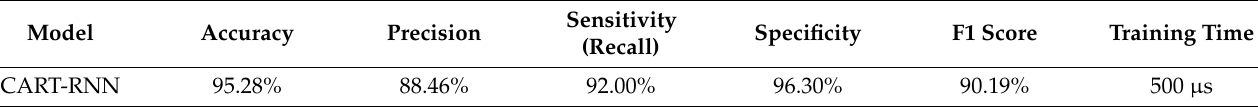
Table 7. Confusion matrix indicators: CART-RNN.